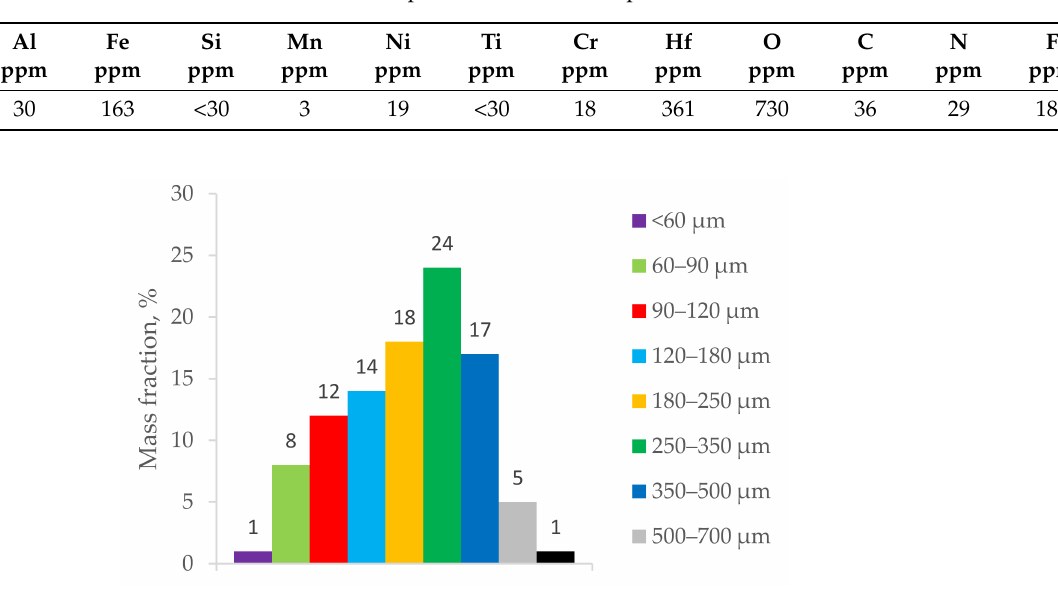
Table 1. Chemical composition of zirconium powder.